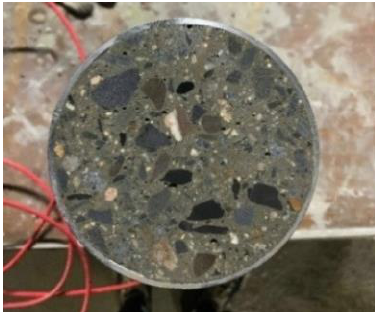
Figure 2. Cross section of CFT specimen.